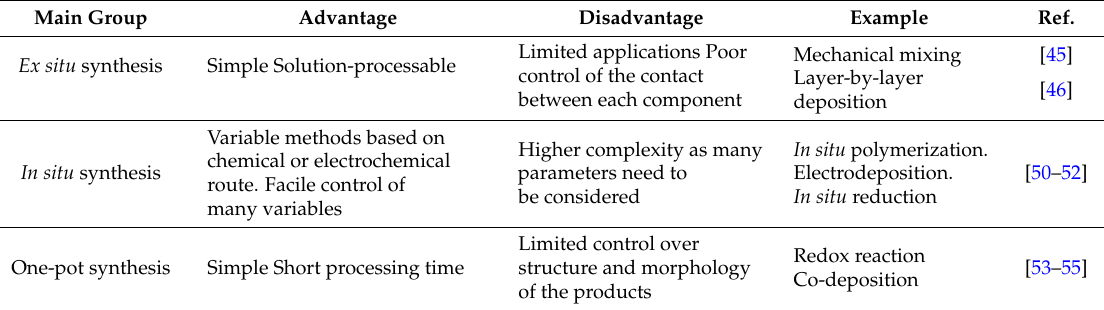
Table 3. Preparation methods for synthesizing CP